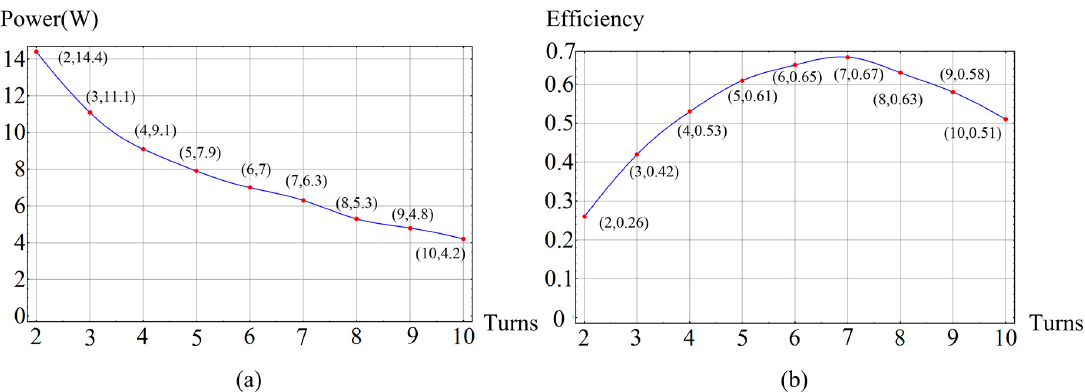
Figure 18. ( a ) Experiment results of power load related to windings; ( b ) Experiment results of efficiency related to windings.